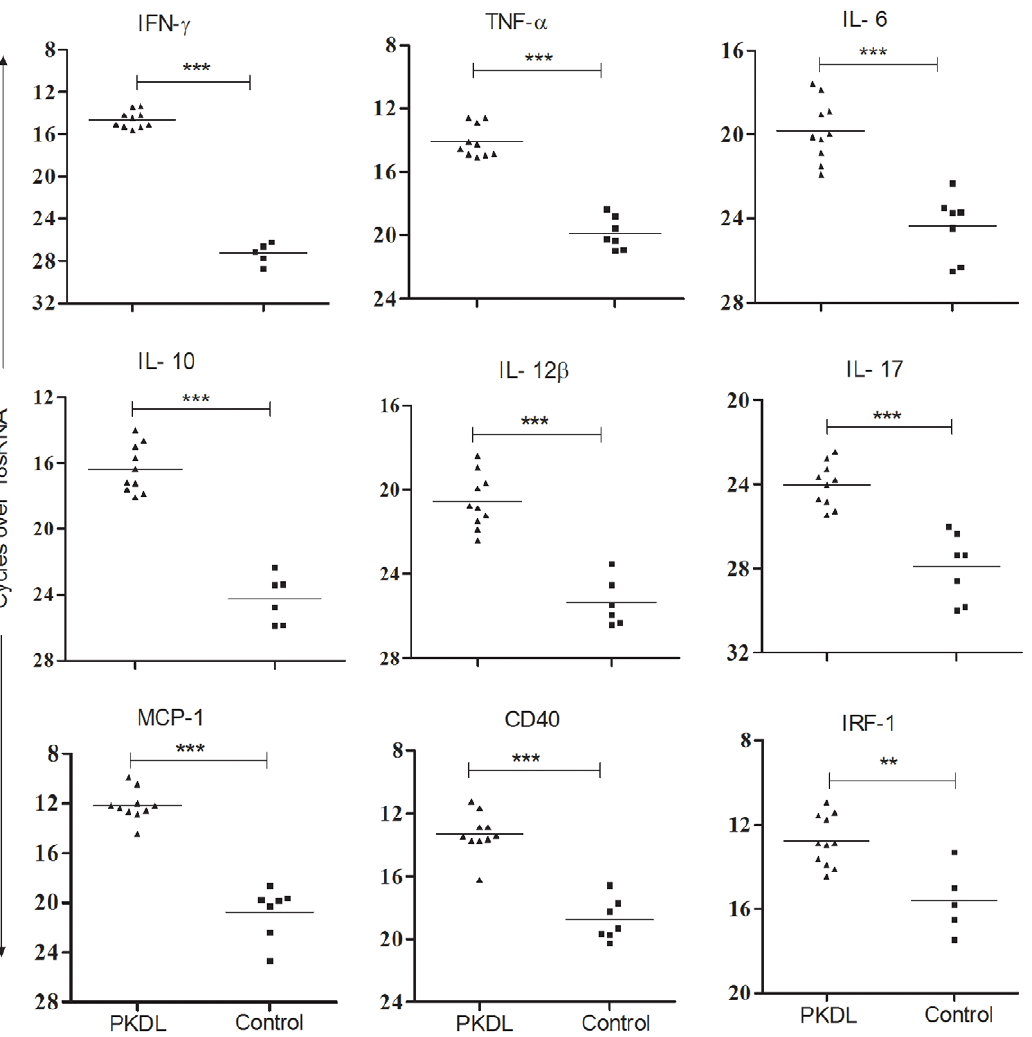
Figure 1. Validation of cDNA array results using real time PCR in tissue lesions of PKDL patients. Relative mRNA levels of IFN- c , TNF- a , IL- 6, IL-10, IL-12 b , IL-17, MCP-1, CD40 and IRF-1 was determined by QPCR in tissues lesions of PKDL patients (n=10) or control tissues (n=7). The relative quantification of products was determined by the number of cycles over endogenous control (18sRNA) required to detect the gene expression of interest. **P , 0.01, and ***P ,